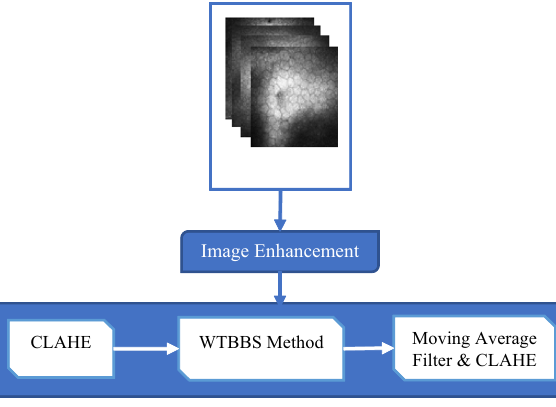
Figure 3: The pre - processing